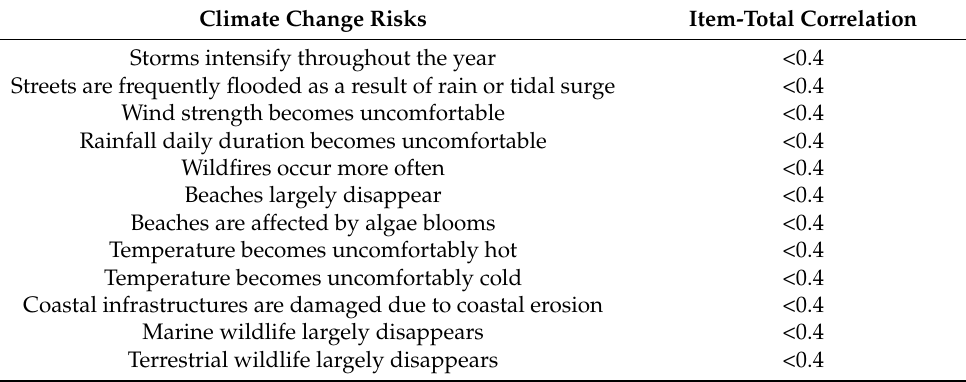
Table 2. Reliability analysis of the climate change risks